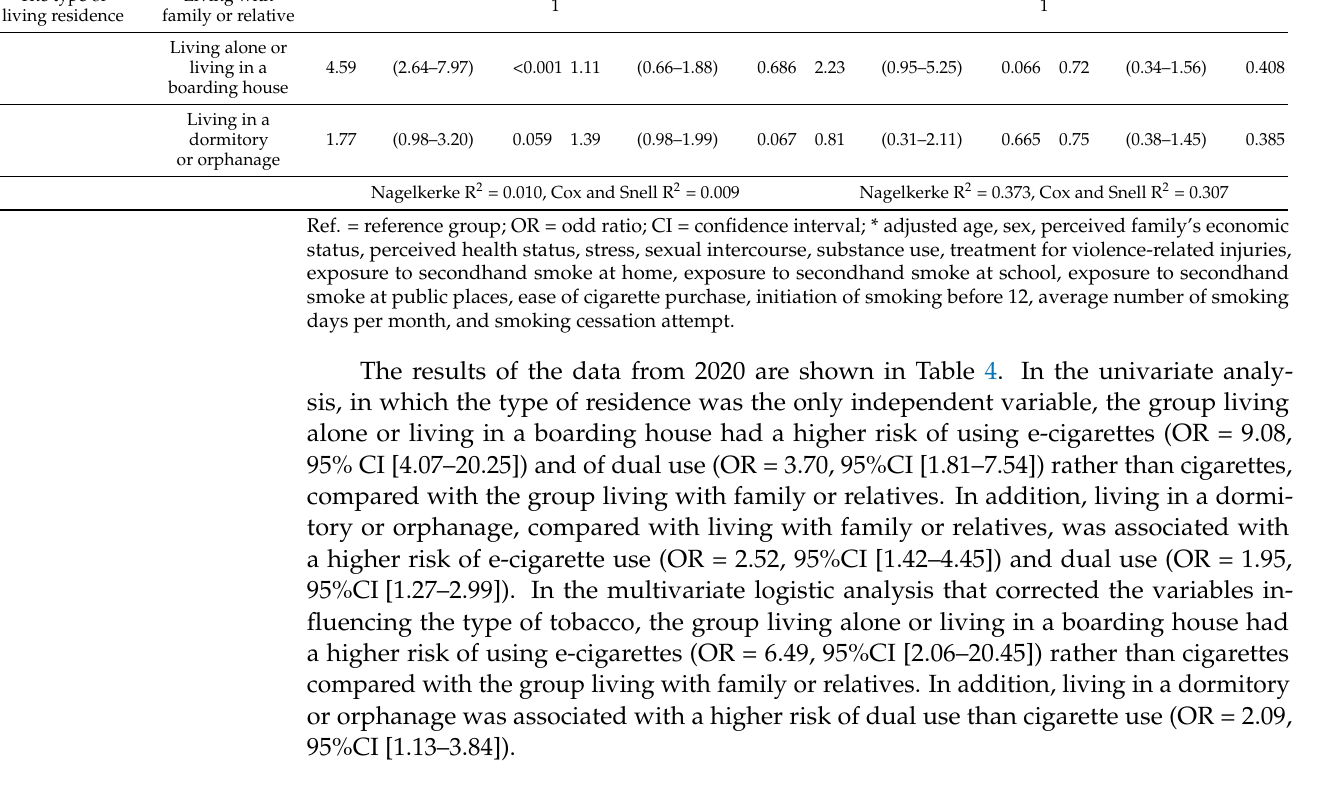
Table 4. Impact of the residence type of the participants on tobacco type during the COVID-19 pandemic